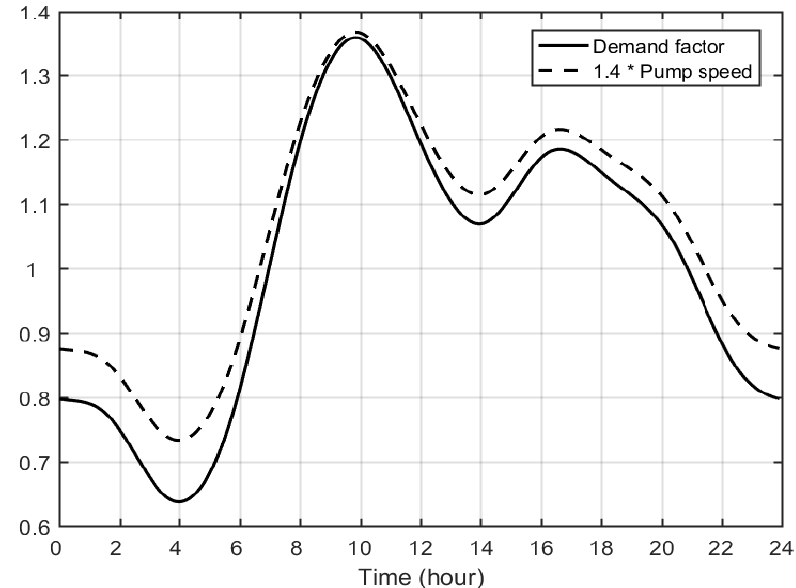
Figure 2. Demand factor (with daily average 1) over one day. Pump speed needed for PM over one day (scaled).